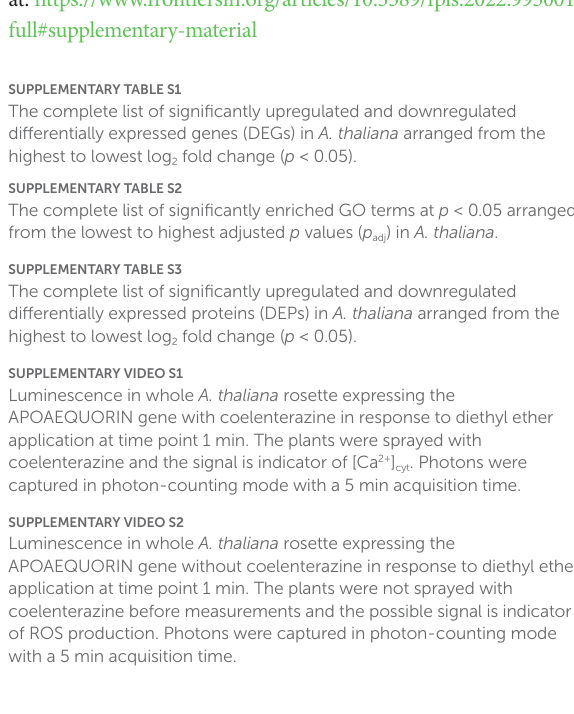
coelenterazine before measurements and the possible signal is indicator of ROS production. Photons were captured in photon-counting mode with a 5 min acquisition